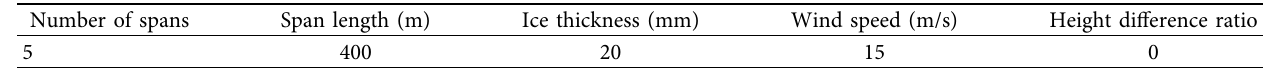
Table 10: Load input conditions of electric power